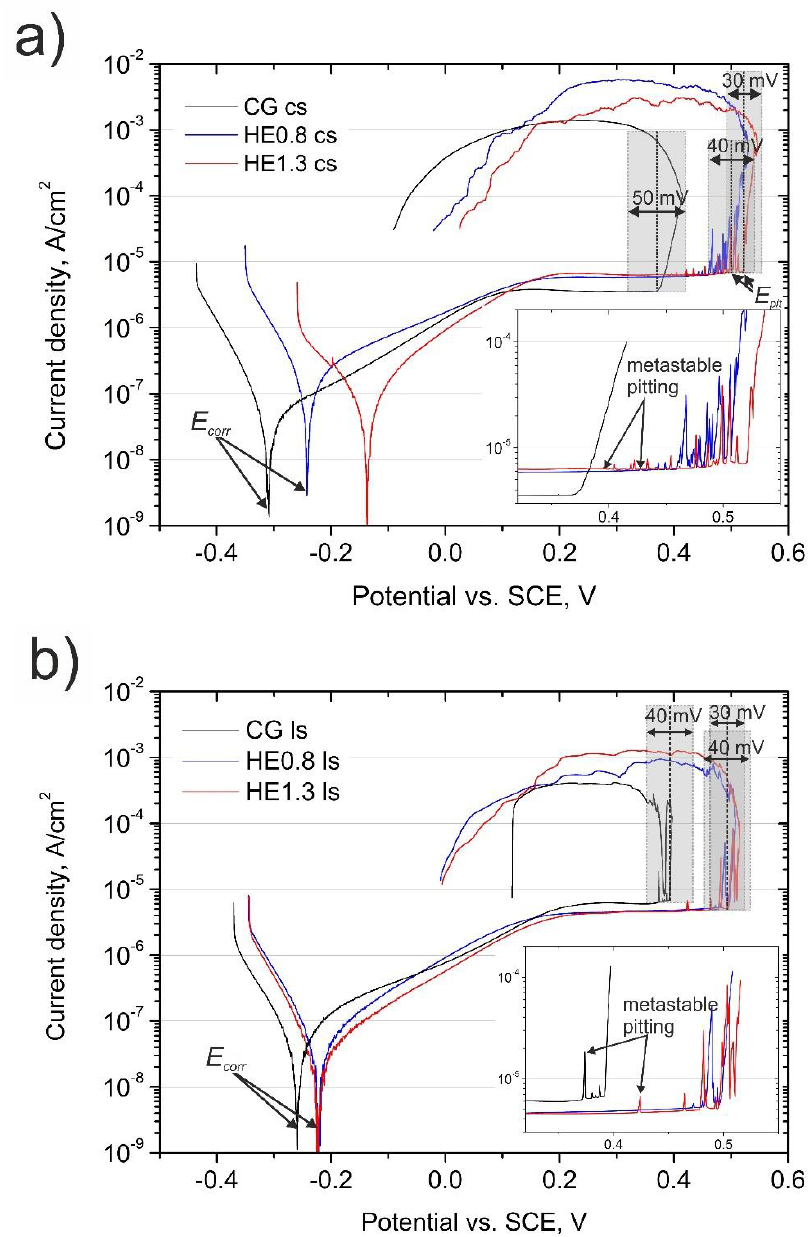
Figure 5. Anodic potentiodynamic polarization curves of CG, HE0.8 and HE1.3 samples recorded in borate buffer (0.1 M H 3 BO 3 + 0.024 M Na 2 B 4 O 7 ) with the addition of 0.1 M NaCl: ( a ) cross and ( b ) longitudinal section.